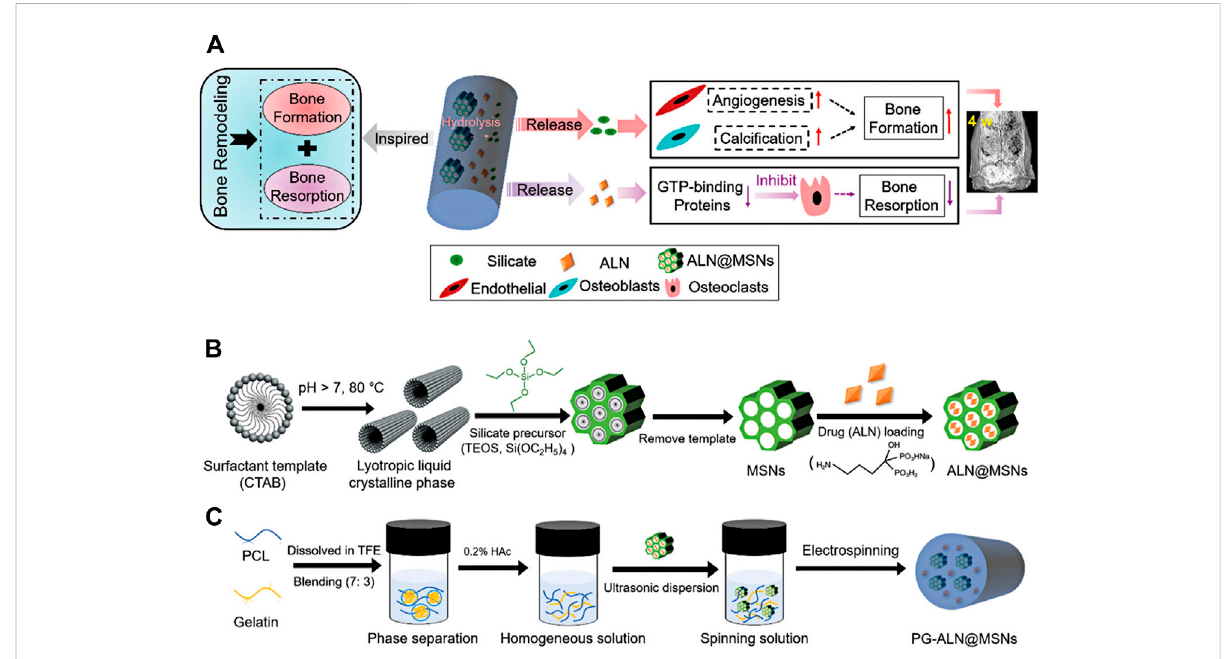
FIGURE 4 SchematicillustrationofPG-ALN@MSNfabricationprocessandeffectsofpreparednano fi bersonbonerepair.ThemechanismofactionofPG- ALN@MSNforimprovingthebonehealingprocess (A) .PreparationofALN@MSNs (B) .ElectrospinningofPG-ALN@MSNnano fi bers (C) .Adaptedwith permission from (Wang et al., 2018b). Copyright 2018 Royal Society of